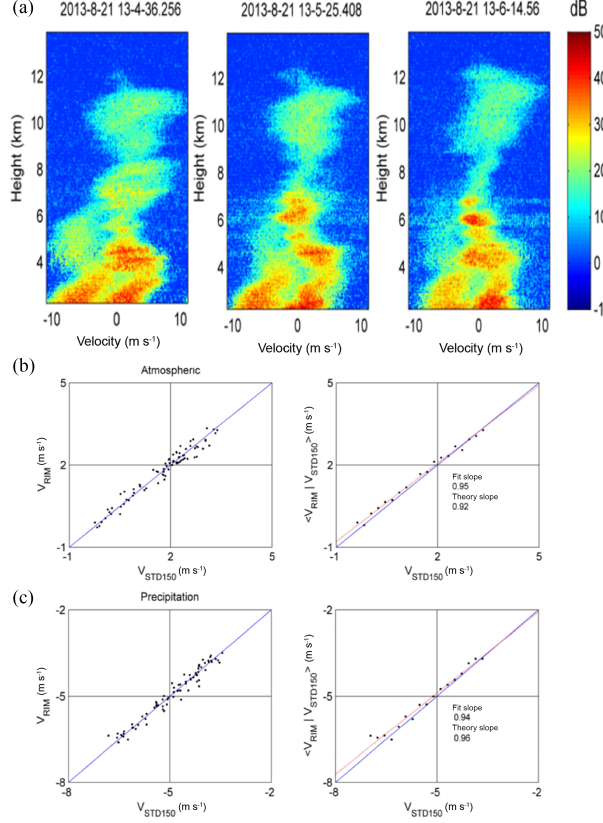
Figure 8. Same as in Fig. 7, except in convective precipitation con- ditions. Data time and date: 13:04:36–13:06:14UT, 21 August 2013 (red line is the fit